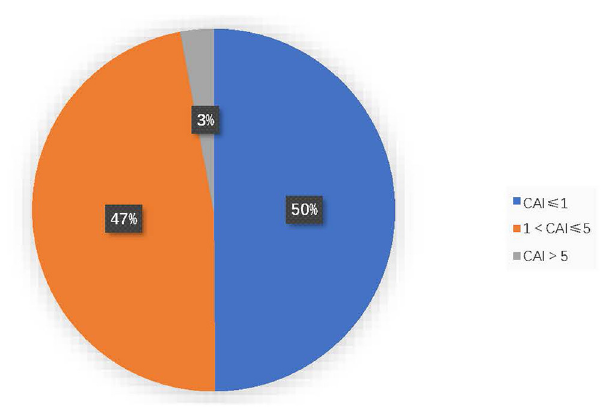
FIGURE 1 | Distribution of different degrees of CAI in children with